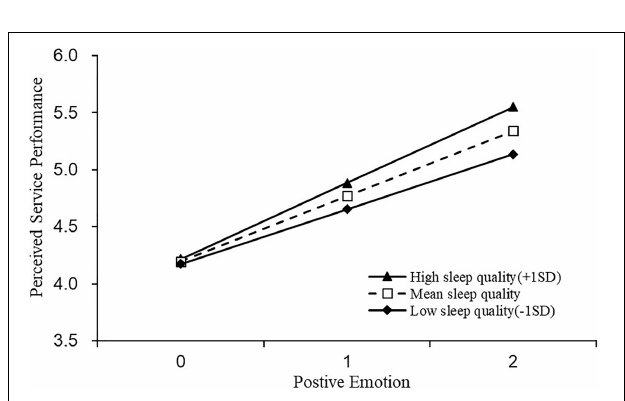
FIGURE 3 | The moderating effect of RESE on the relationship between negative emotions and perceived service performance.